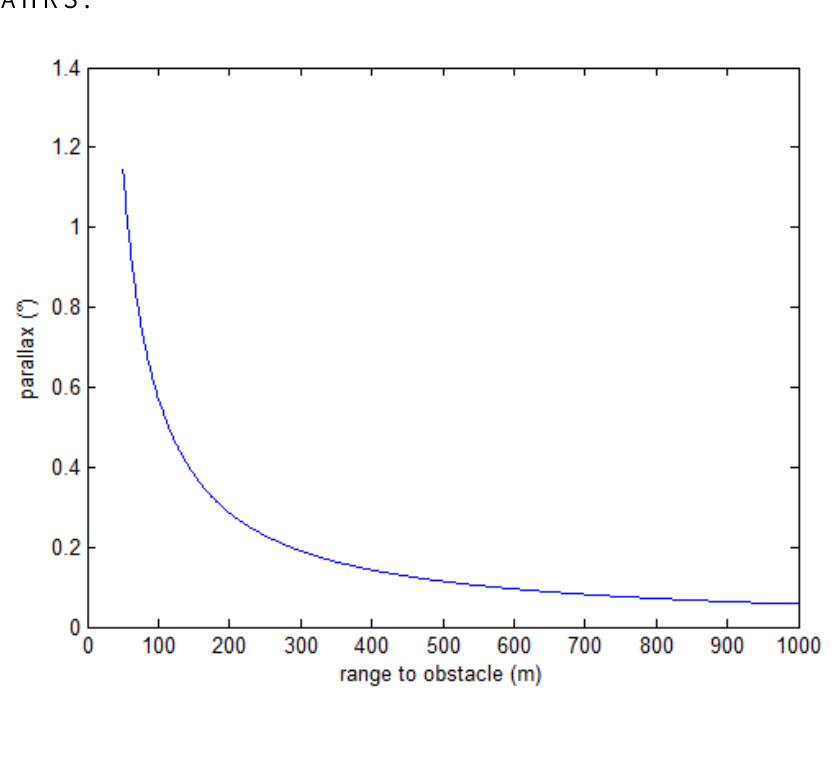
Figure 2. Parallax effect as a function of range to obstacle for a 1 m separation between camera and